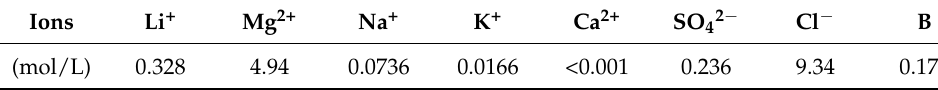
Table 2. Major components in brine.